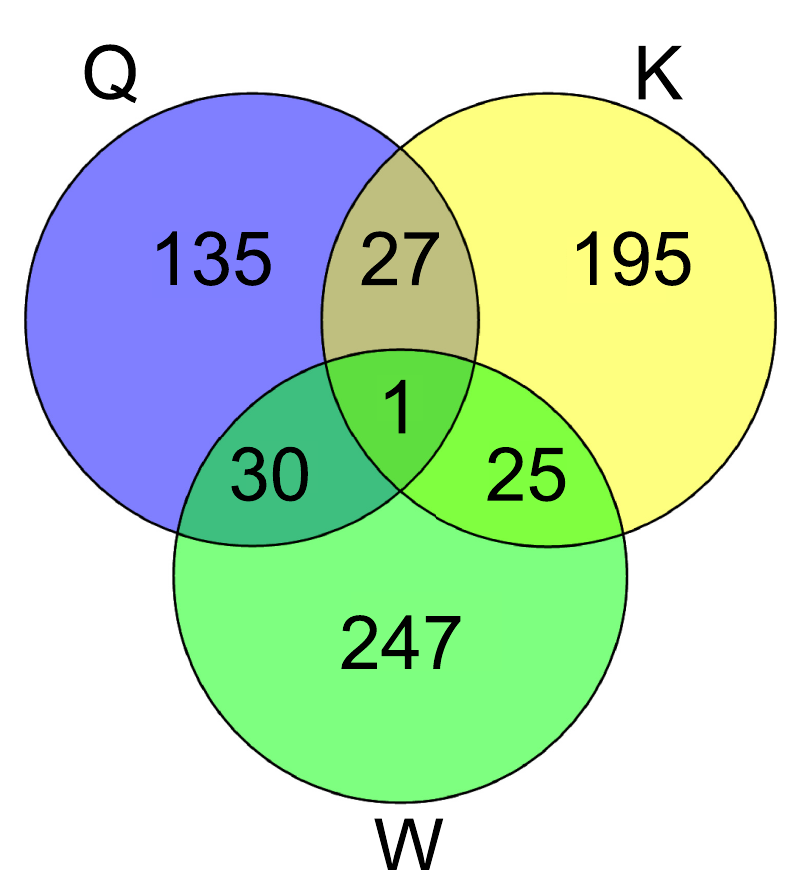
Fig 3. Venn diagram of differentially expressed transcripts. Shared differentially expressed transcripts (DETs) with age (old vs. young) between C . secundus queens (Q), kings (K) and workers (W). Blue: old queens vs young queens, yellow: old kings vs young kings and green: old workers vs young workers.